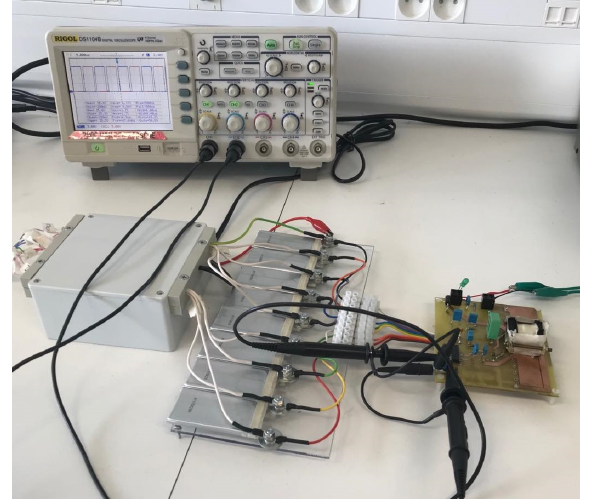
Figure 10. The photograph of experimental setup of the proposed transformer balancing circuit.